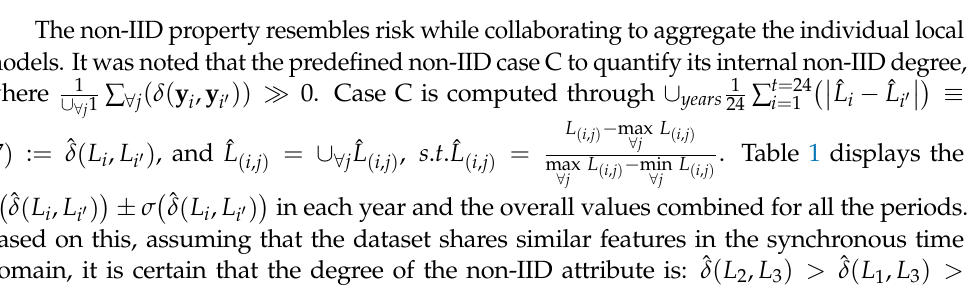
Figure 2. Visualization sample ( a , b ) of daily solar energy generation and its distribution ( c , d ).